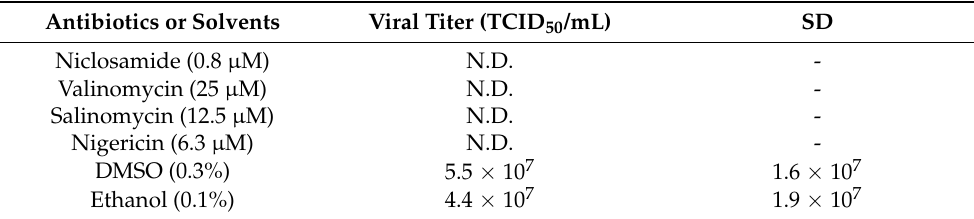
Figure 3. Ionophore antibiotics inhibit FCoV replication in a dose-dependent manner by RT-qPCR. Total RNAs from the supernatants of the infected cells were treated as described in the Materials and Methods section; they were extracted and analyzed by RT-qPCR. Each sample was assessed through triplicate measurements. Error bars indicate standard deviations. Data were analyzed with one-way ANOVA with Dunnett’s multiple comparison test (* p < 0.05; ** p < 0.001). FCoV, feline coronavirus; RT-qPCR, reverse transcription-quantitative polymerase chain reaction. Table 1. Antiviral activities of ionophore antibiotics in Fcwf-4 cells based on TCID 50